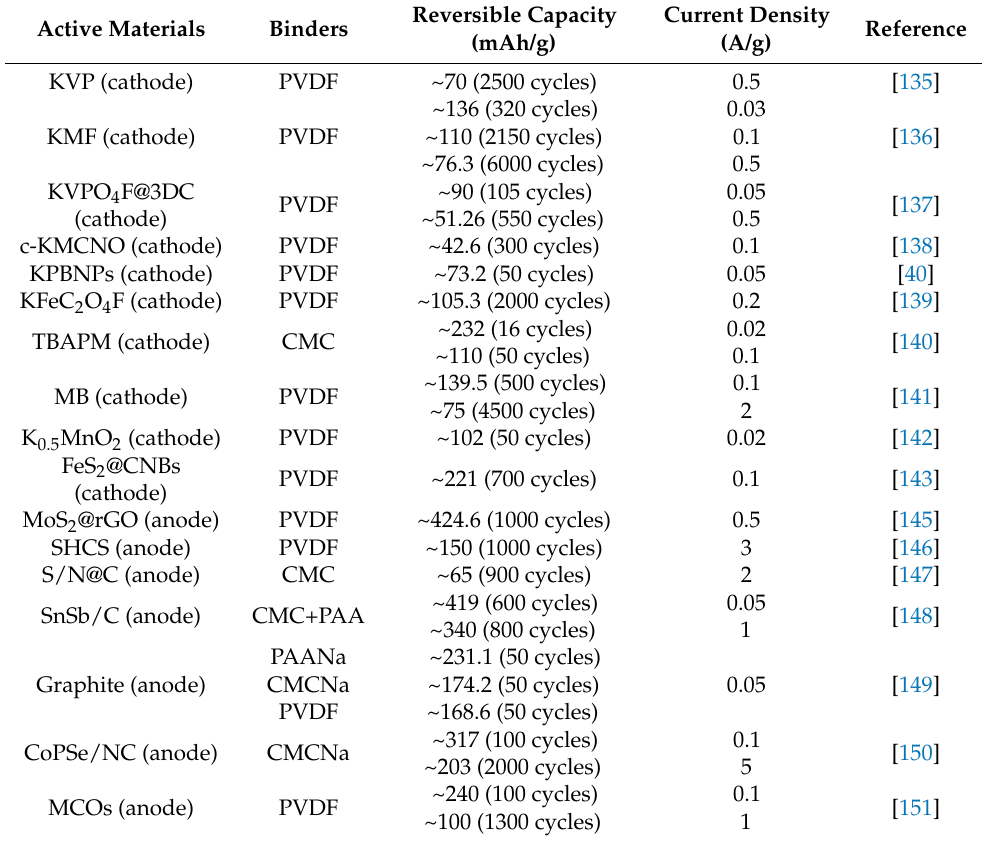
Table 4. Application of some representative binders in